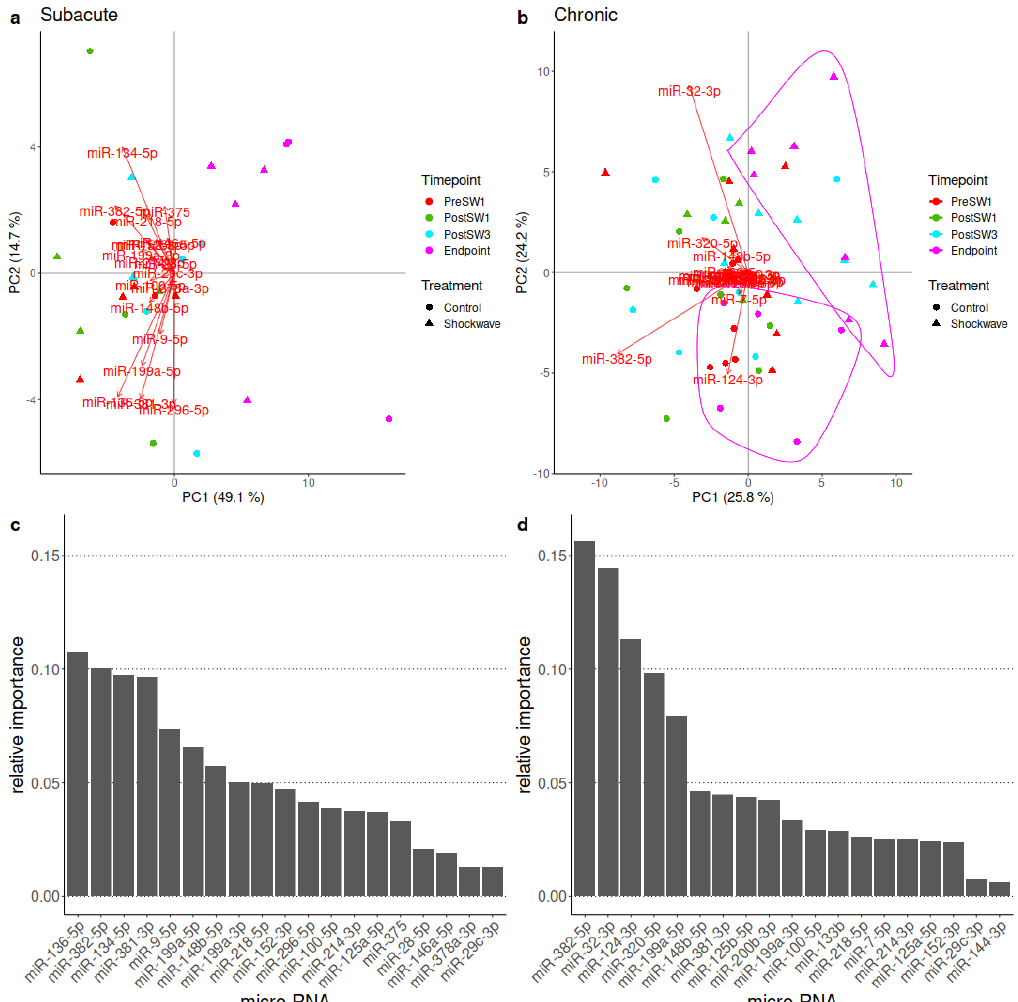
Figure 8. PCA (principal component analysis) results of miRNA RT qPCR. ( a , b ) PCA biplots. Vectors are loadings of the miRNAs, while the points are the samples in the coordinate system made up of the first two principal components. ( a ) Subacute biplot, ( b ) chronic biplot; apparent clusters of endpoint samples encircled, ( c ) relative feature importance of the subacute setting, ( d ) relative feature importance of the subacute setting.